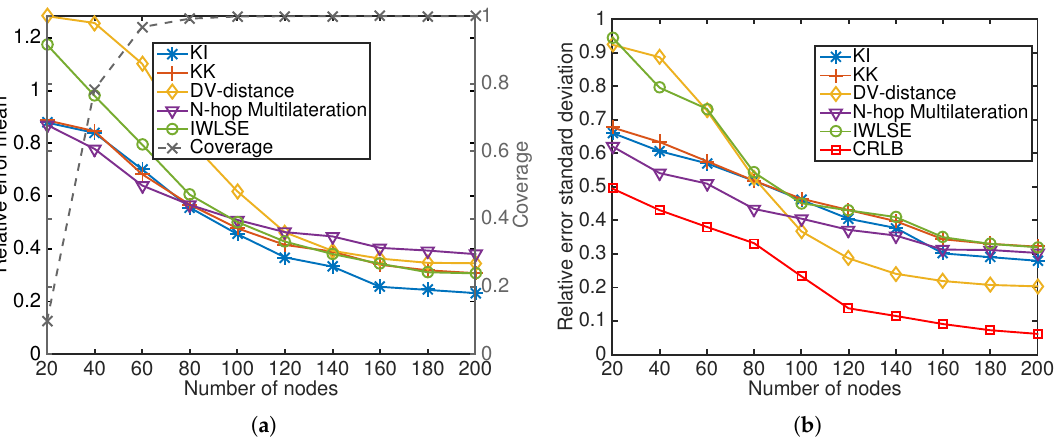
Figure 9. ( a ) Average estimation error and coverage, ( b ) SD as a result of changing the number of nodes. Area size: when the area size of the network increases, the relative error mean and SD increase for all algorithms as shown in Figure 10. The result is consistent with results of changing number of nodes, as they are both changing the density of the network when other parameters are kept the same.